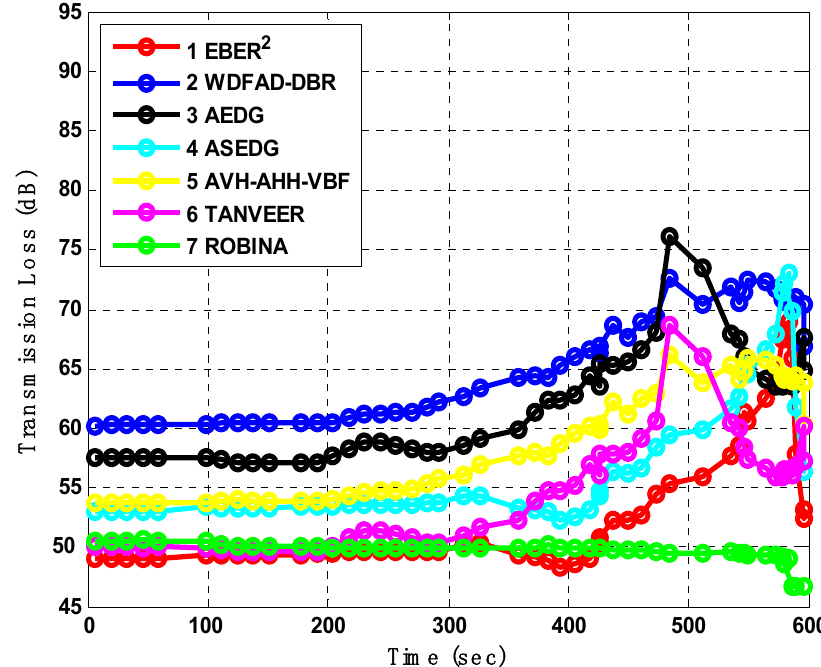
Figure 9. Analysis of End-to-End average delay with baseline schemes.